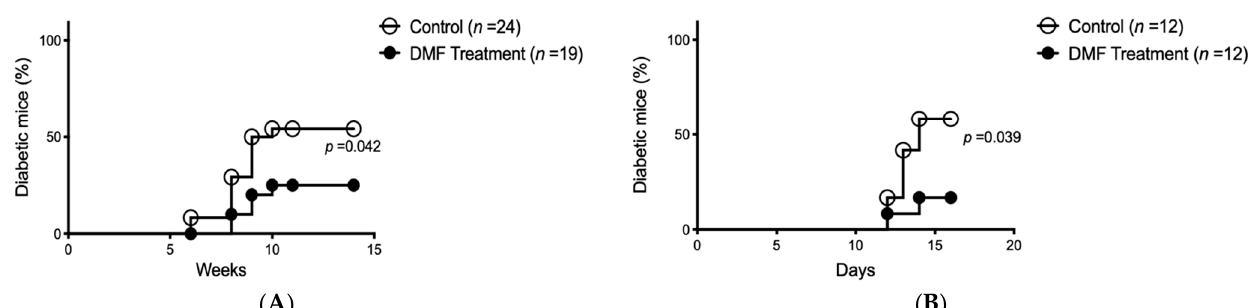
Figure 3. DMF treatment reduces diabetes onset in spontaneous and accelerated non-obese diabetic (NOD) diabetes model. ( A ) Spontaneous diabetes onset in NOD mice was significantly decreased in the DMF-treated group compared to the control group (* p = 0.042) at 14 weeks. ( B ) In cyclophosphamide-induced accelerated NOD diabetes model, DMF treatment significantly decreased the incidence of diabetes compared to the control group ( p = 0.039) at 2 weeks.